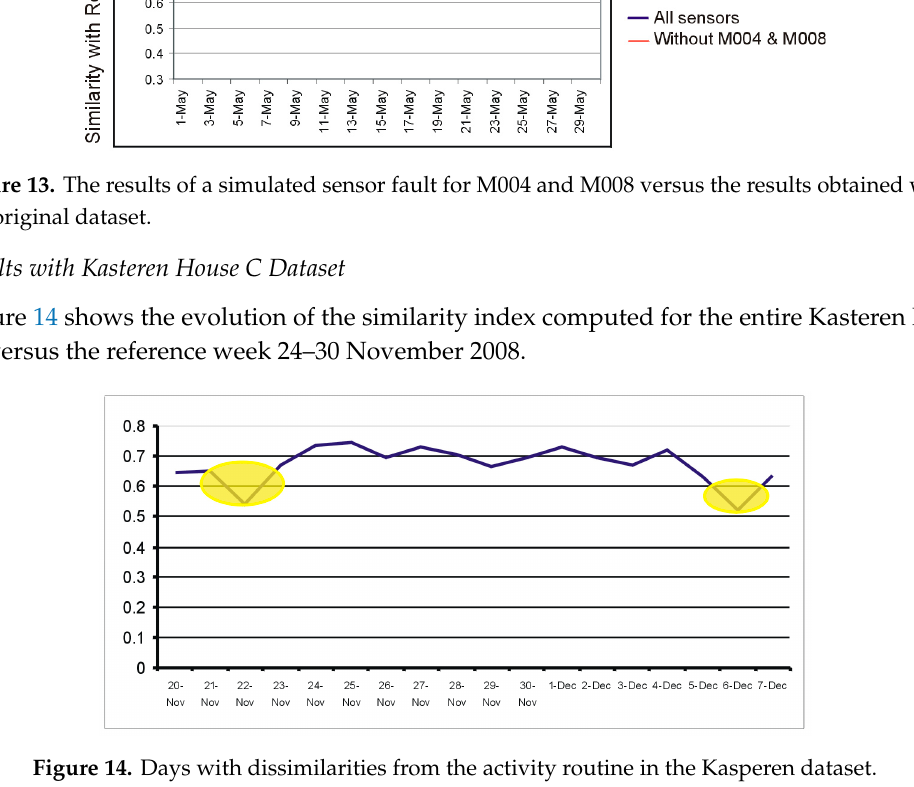
Figure 14. Days with dissimilarities from the activity routine in the Kasperen dataset.